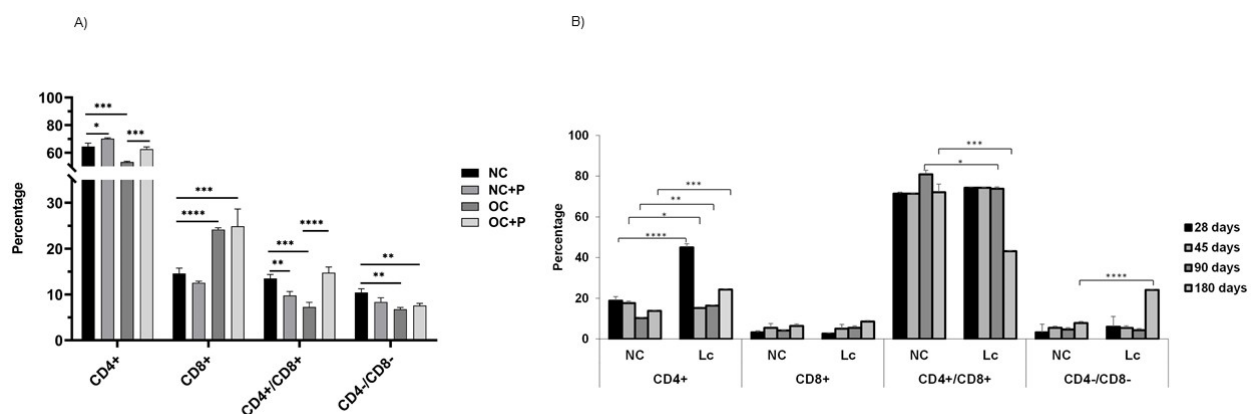
Figure 4. Determination of CD4 and CD8 (single- and double-positive) T lymphocytes in thymus. The number of CD4+ and CD8+ cells was determined by flow cytometry in both models: ( A ) obese mice with or without probiotic supplementation; ( B ) senescence animal model at different mice ages (21, 28, 45, 90 and 180 days) with or without probiotic consumption. Results were expressed as means of the percentages of positive cells obtained from 3 mice per group and repeated in 3 independent experiments. One-way ANOVA with Tukey’s correction for multiple comparisons * p < 0.05; ** p < 0.001; *** p < 0.001; **** p < 0.0001.